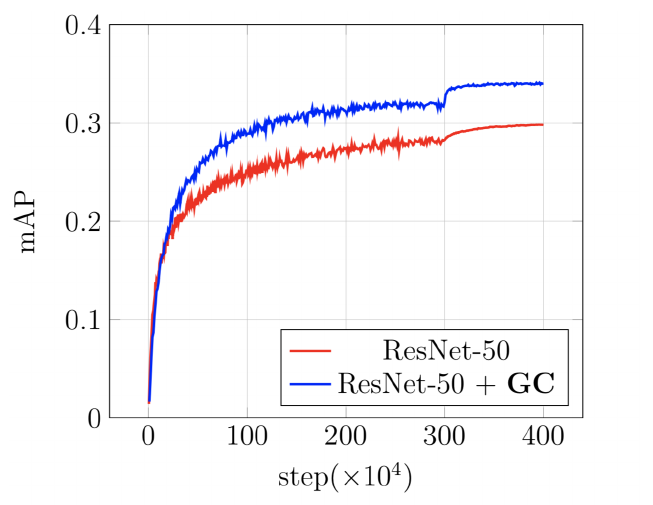
Figure 5. Comparisons of evaluation curves on the COCO val2017 dataset with Adam + SGD optimizer.